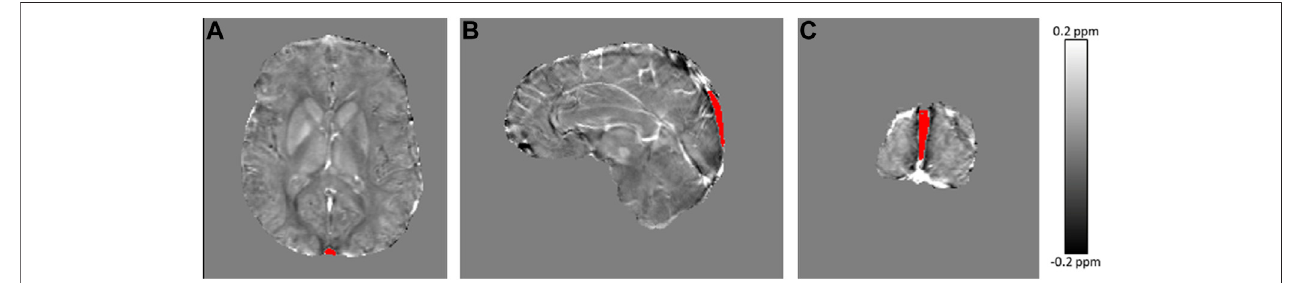
FIGURE 2 | Axial (A) , sagittal (B) and coronal (C) view of the average susceptibility map calculated across MPM acquisitions in a representative sickle cell anemia subject, with the segmented region of interest in the superior sagittal sinus overlaid in red.